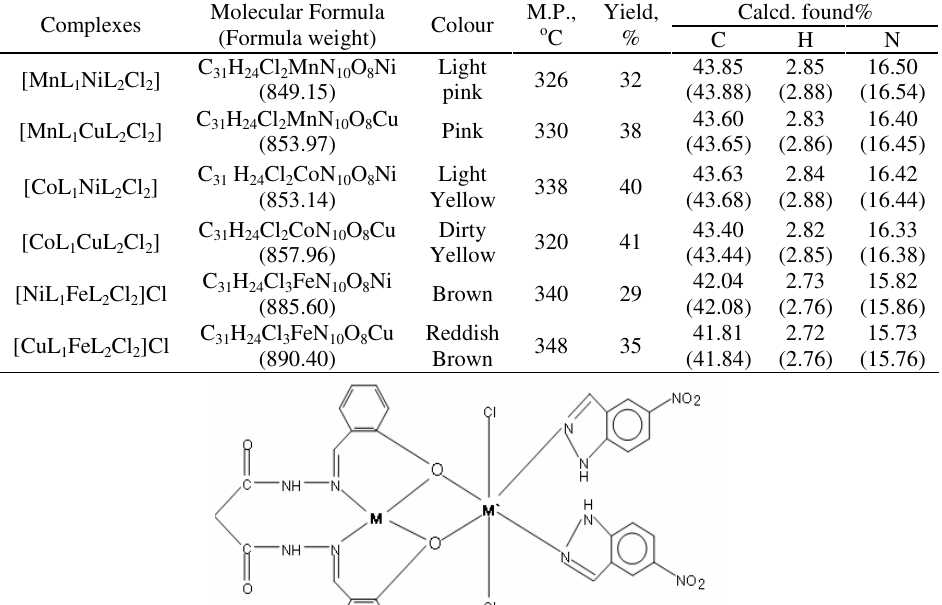
Table 1. Analytical data of heterobinuclear complexes